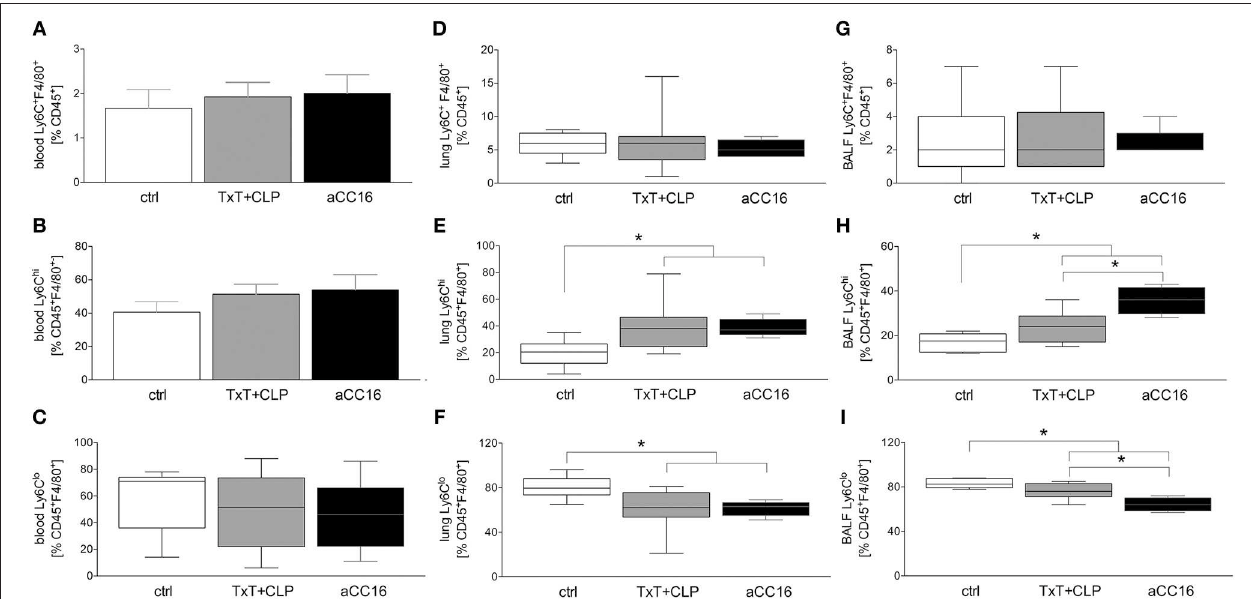
FIGURE 4 | Impact of CC16 neutralization on distribution of macrophage subsets following thoracic trauma (TxT) with cecal ligation and puncture (CLP). Amount of macrophages (Ly6C + F4/80 + ) as well as of the pro-inflammatory (Ly6C hi ) and patrolling (Ly6C lo ) subsets was assessed in blood (A–C) , lungs (D–F) and BALF (G–I) by flow cytometry. Data are represented as box-whisker plot and min to max, * p < 0.05 vs.